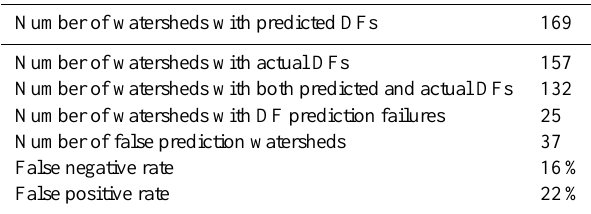
Table 6. Analysis of forecasting results on 9 July